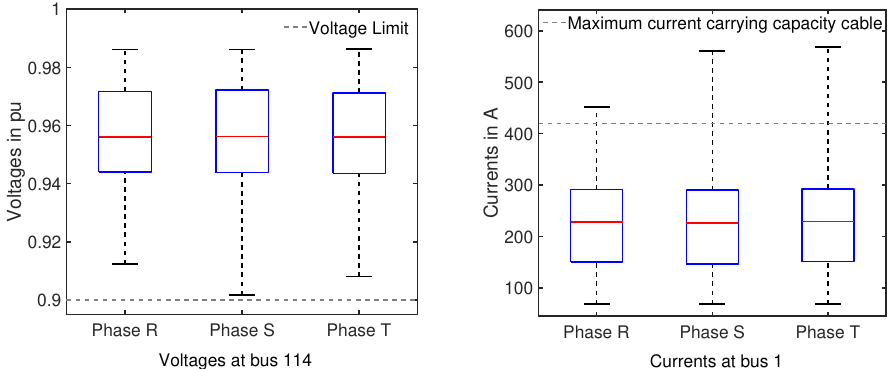
Figure 9. Phase voltages at bus 114 and phase currents at bus 1 for cost optimized vehicle charging.